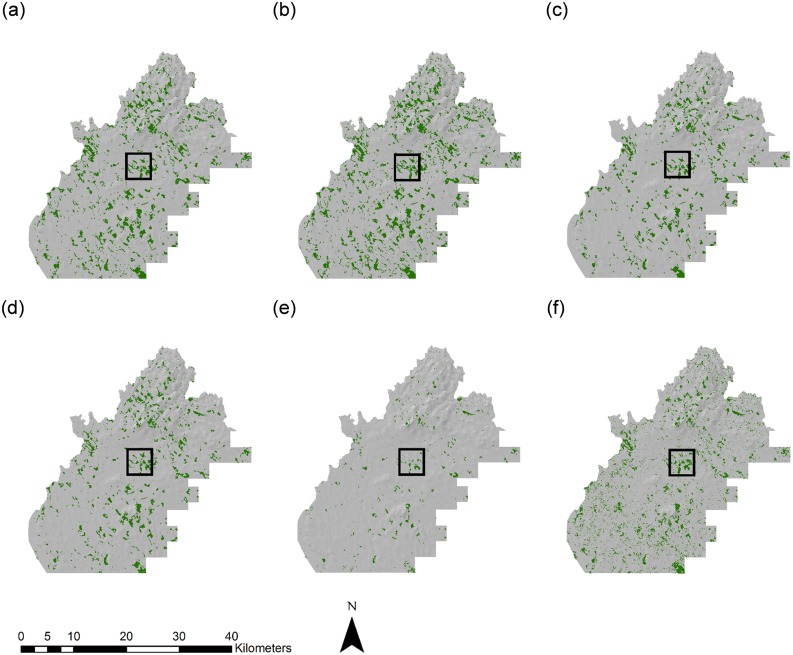
Extent of forest cover in Longford based on (a) SAR RF-5, (b) SAR ERT-5, (c) Forestry2010, (d) Prime2, (e) JRC Forest Map 2006, and (f) Global Forest Change map.The boxed area indicates the zoom-in area shown in Fig 6.